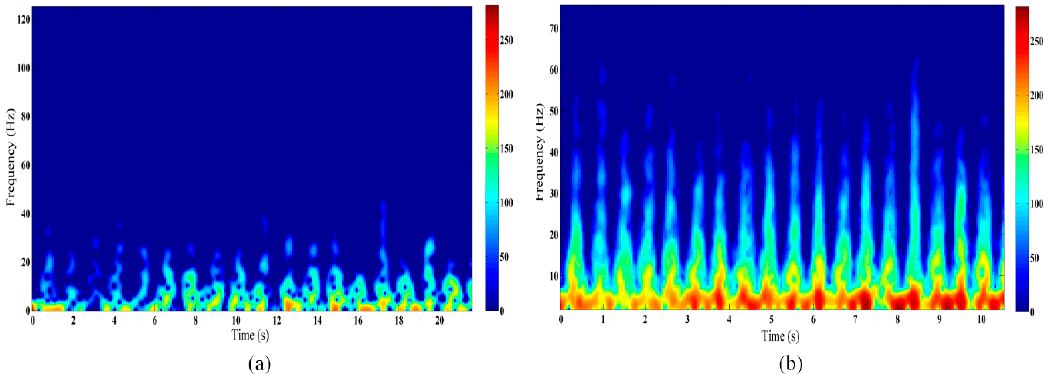
Figure 4. Time-frequency spectra of SFCW radar signal for piaffe at a distance of 4 m behind the wall, based on different range accumulation methods: ( a ) Reference method and ( b ) Proposed method.